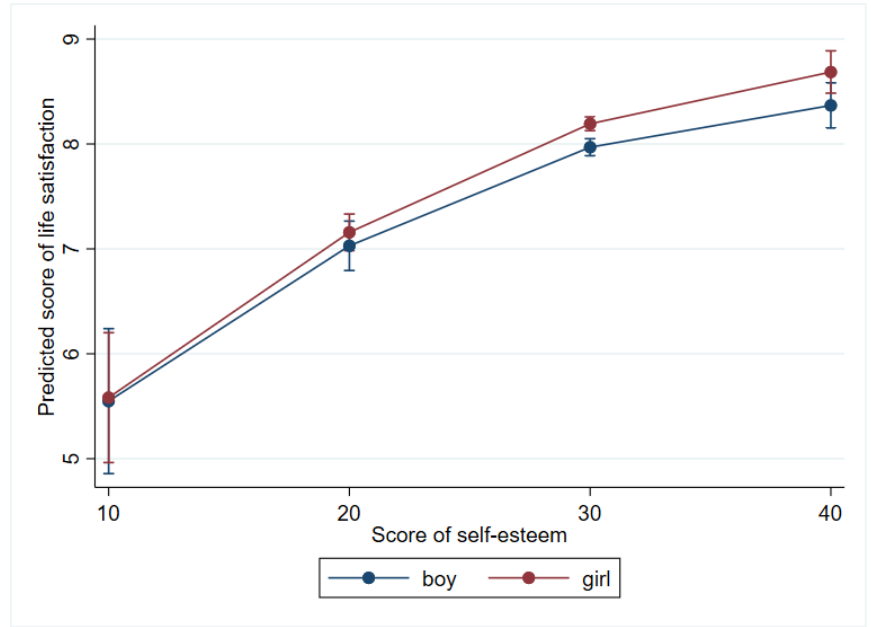
Figure 5. Marginal effects of gender on life satisfaction at different levels of self-esteem.